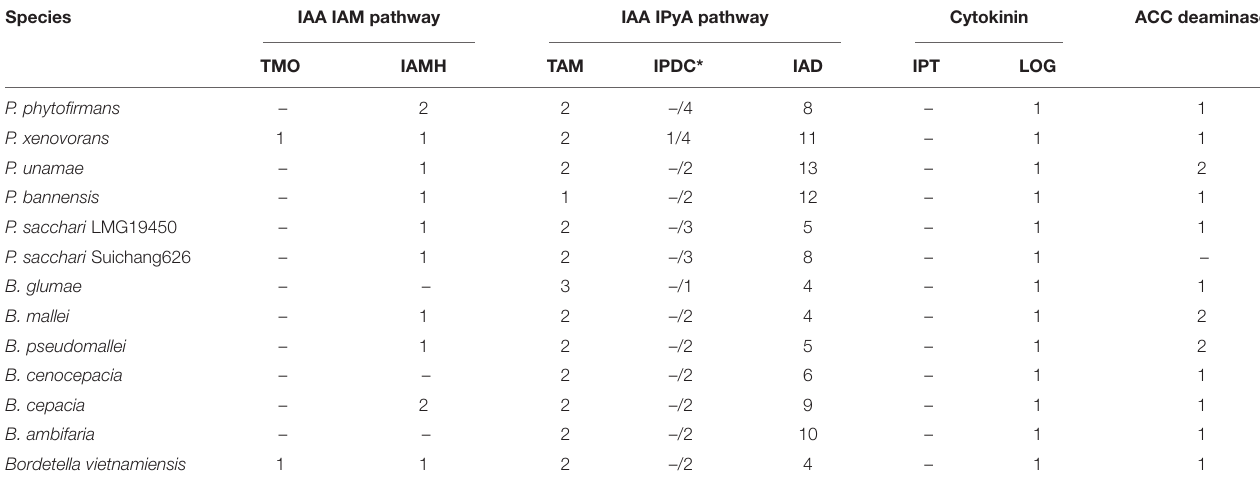
TABLE 5 | Homologs of bacterial plant hormone biosynthesis and modification genes.